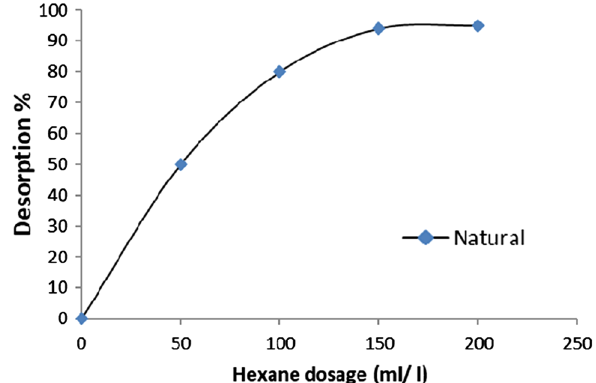
Fig. 11 Effect of hexane concentration on the removal efficiency of oil emulsion by RC